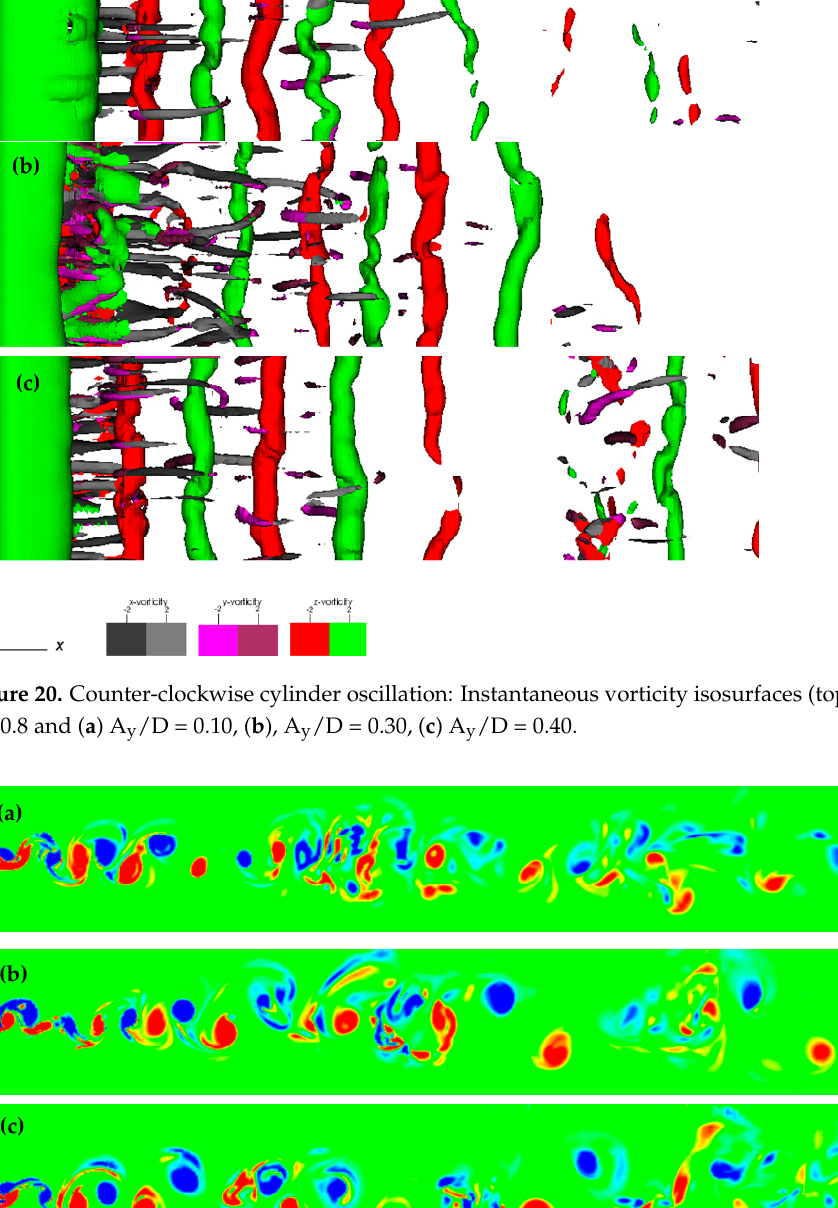
Figure 19. Clockwise cylinder oscillation: Instantaneous isocontours of spanwise vorticity for the plane z = 3 for F = 1.1 and ( a ) A y /D = 0.10, ( b ), A y /D = 0.30, ( c ) A y /D = 0.60.